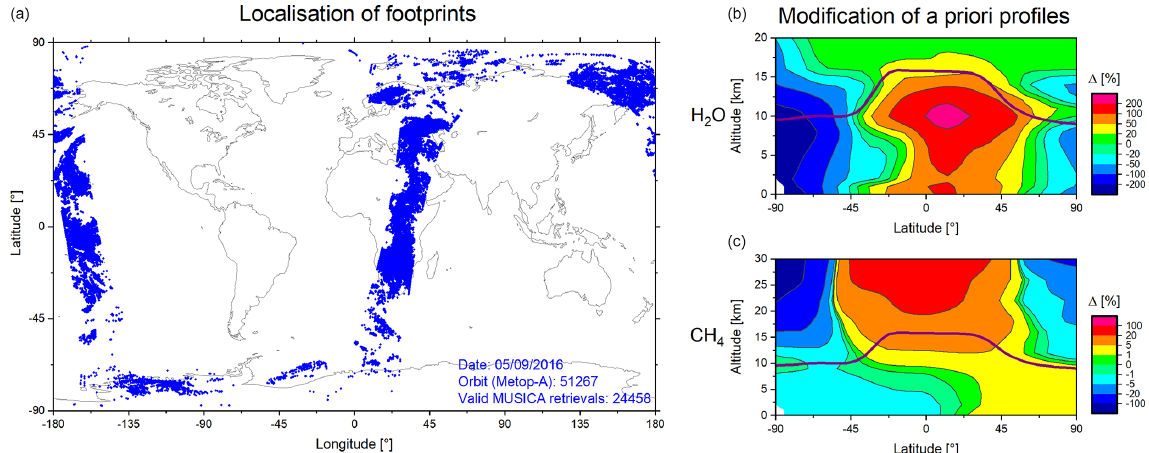
Figure B1. Setup of the linearity test using modified a priori data. (a) The localisation of the footprints of the exemplary orbit used and (b, c) latitudinal cross sections documenting the modification of the H 2 O and CH 4 a priori data (modified − original; the thick solid violet line indicates the tropopause altitude).